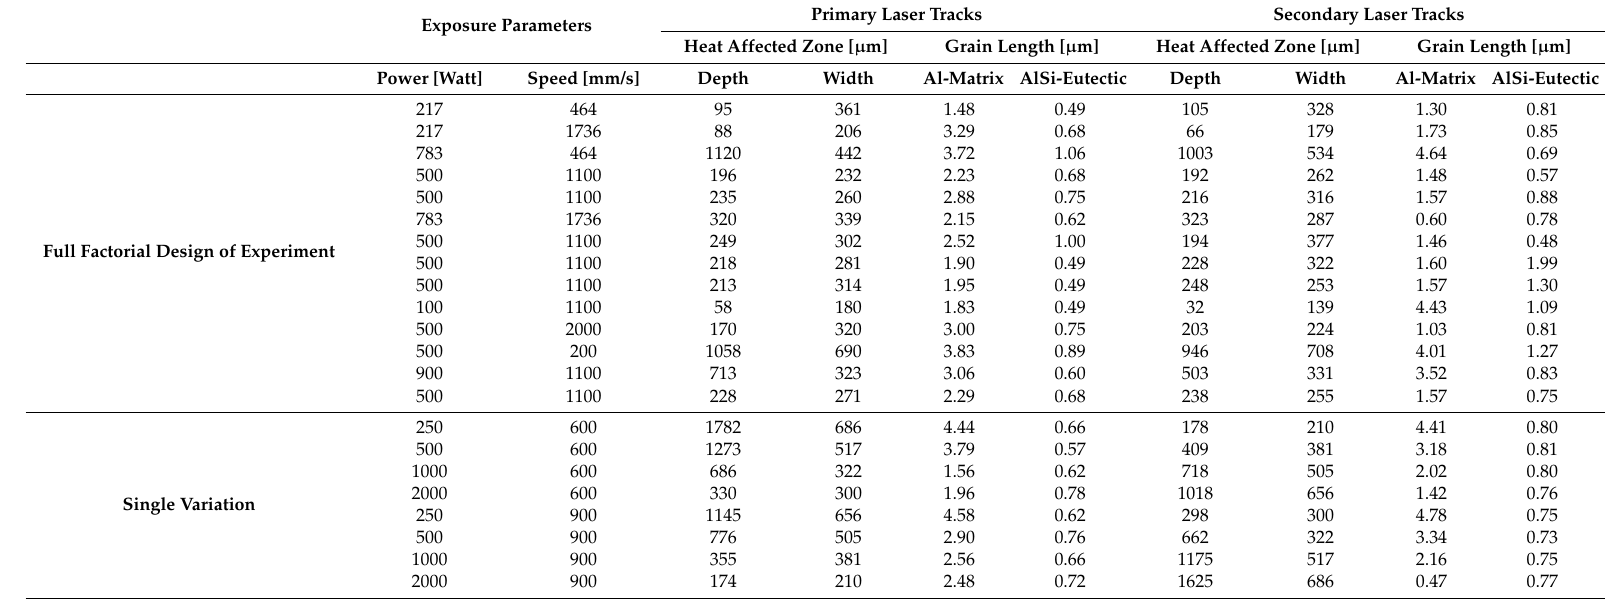
Table A1. Measured values regarding melt pool dimension and grain size. Results regarding melt pool dimensions represent the arithmetic mean of three measured specimens. The application of an Anderson Darling test confirms a normal distribution for the